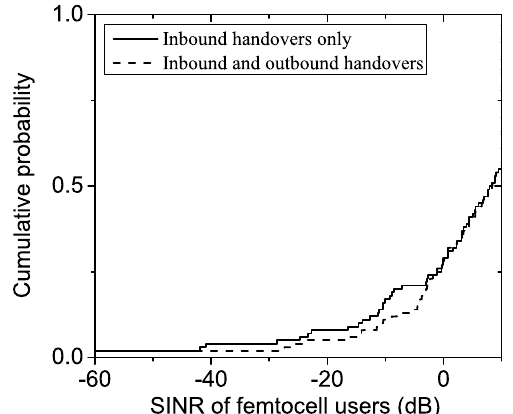
Figure 10. Probability distribution of femtocell users’ achieved SINRs when allowing inbound handovers only and when allowing both inbound and outbound handovers ( M = 50, F = 100).